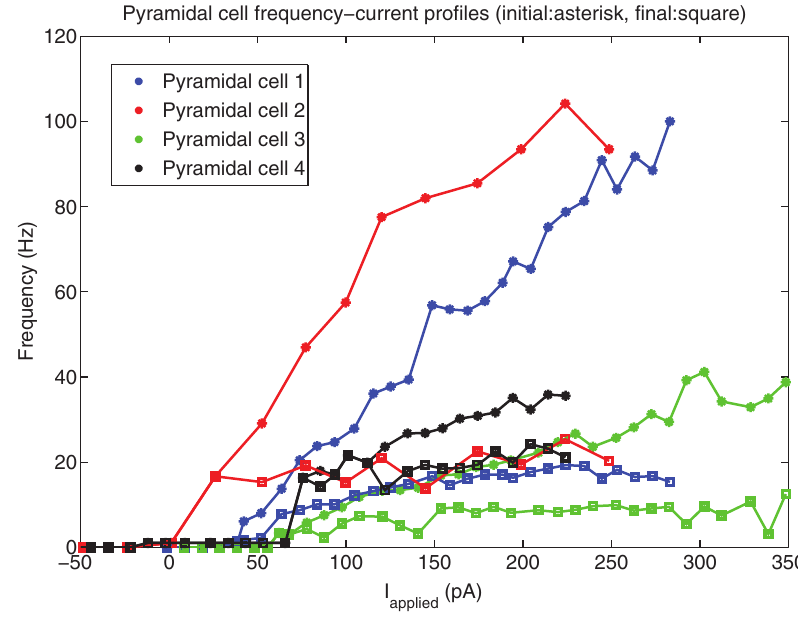
Figure 2. The initial and final frequency current profiles for the four pyramidal cell recordings (from three mice) in the CA1 region of the intact hippocampal preparation in vitro . 10 pA depolarizing steps were taken for all cells except Pyramidal cell 2 (25 pA steps). The initial (final) frequencies are shown by asterisks (squares), and the lines interpolate between the data points. Pyramidal cells 1 and 2 (shown in blue and red) have higher initial frequencies, and exhibit more adaptation than Pyramidal cells 3 and 4 (shown in light green and